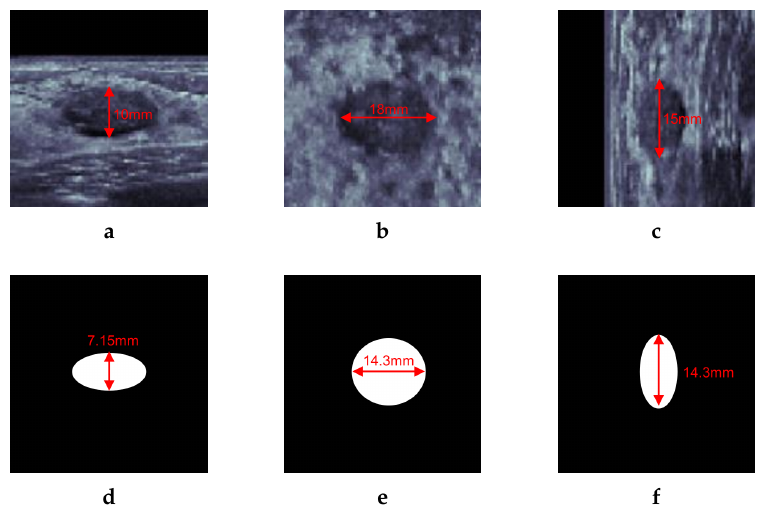
Figure 4. Example of template mask. ( a – c ) Slice image of transverse, coronal, sagittal view of breast cancer on ABUS including diameters of each axis. ( d – f ) template mask matched to ( a – c ). Using average diameter of the lesion, the mask label has two of equal semidiameters of 14.3 mm and 7.15 mm semidiameters, which is the half-length of the other diameters due to parallel orientation